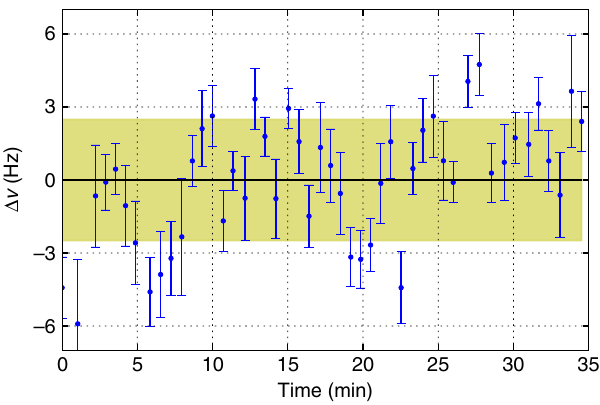
Fig. 6 Stability of the clock laser frequency. The relative frequency of the Tm clock transition and ULE cavity mode with linear drift compensation. Each data point and corresponding uncertainty comes from the fi t of the clock transition spectrum. The shaded region corresponds to 1 s.d. of the data set